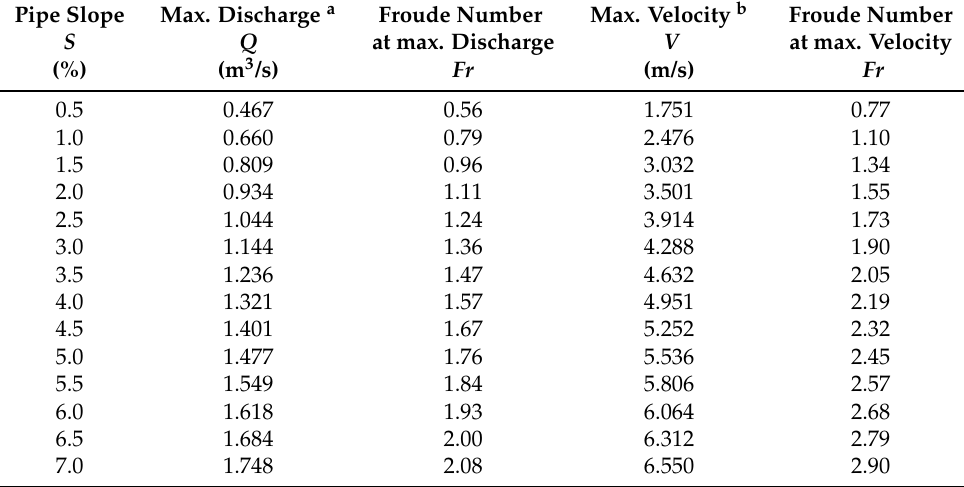
Table 1. Flow characteristics in a circular pipe section with open-channel flow (Figure 2). The pipe diameter is D = 600 mm, and Manning’s n is 0.013.